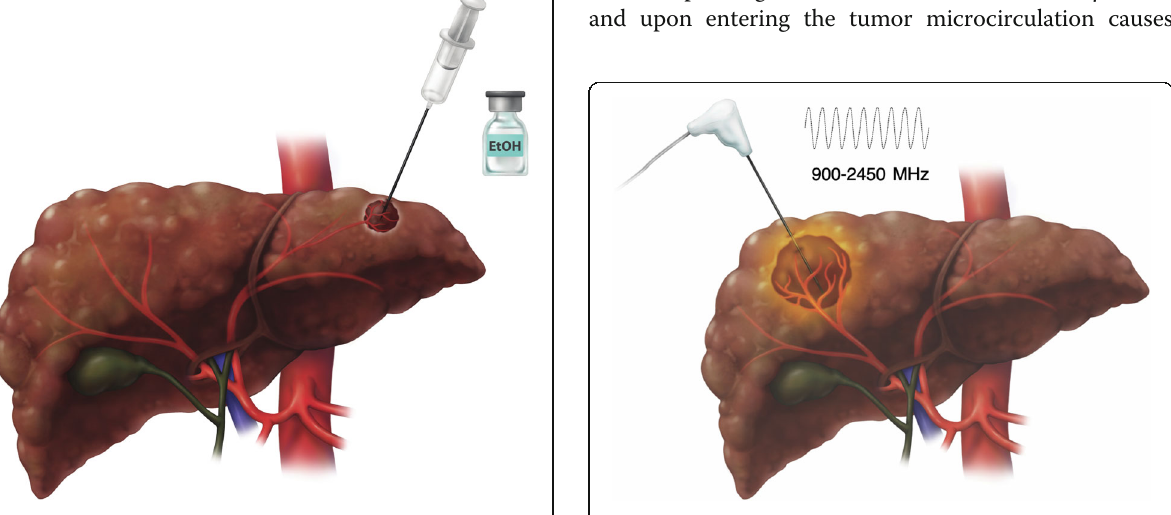
Fig. 4 Percutaneous ethanol ablation (PEA). Absolute ethanol is injected in the tumor. Multiple sessions and prolonged